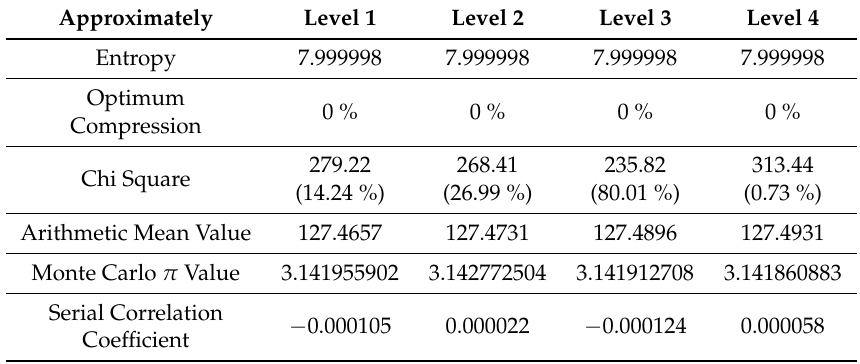
Table 5. ENT results.